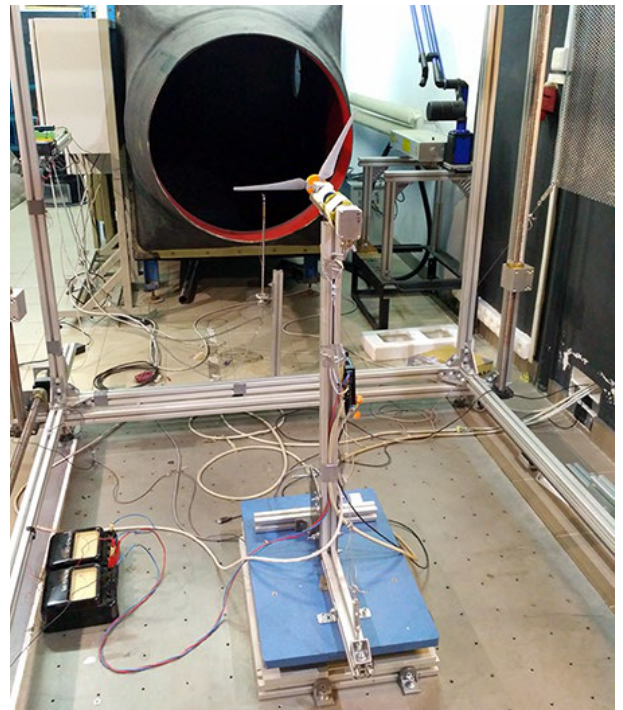
Figure 7. Full view of the test stand mounted in the open section wind tunnel.